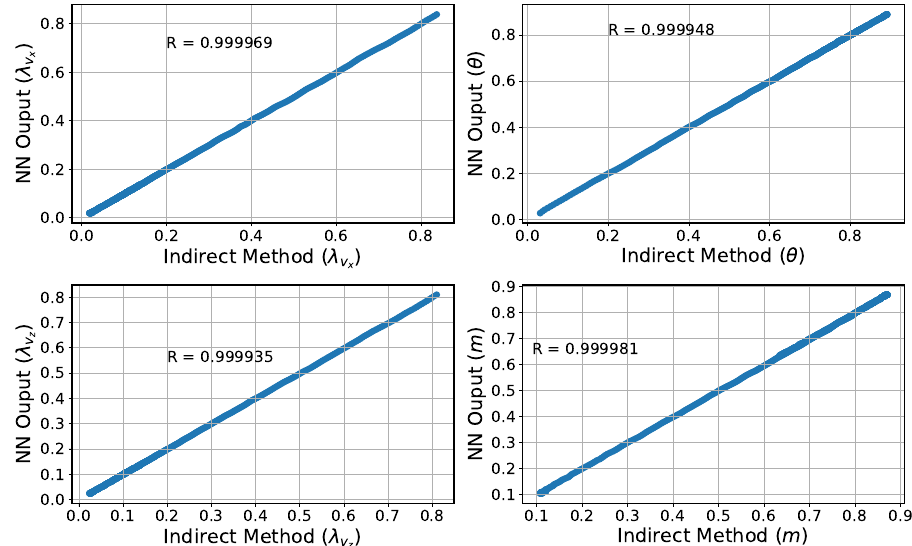
Figure 10. The regression analysis results between the predicted and the standard for